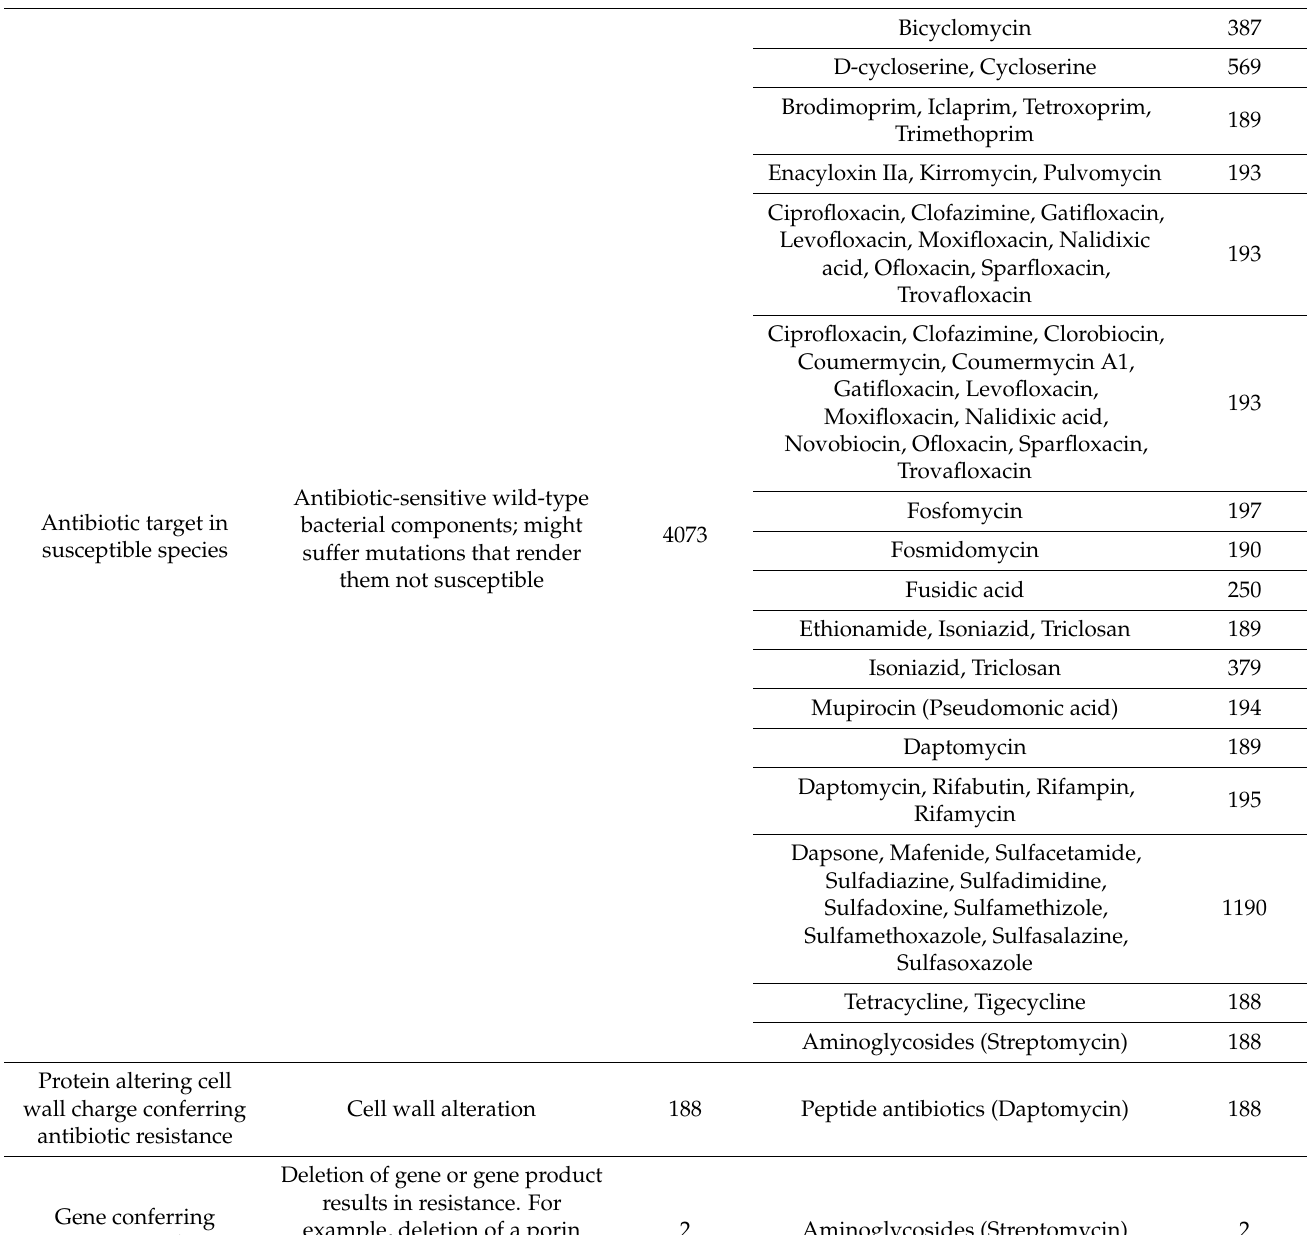
Table 2. Putative ARG detected within 189 A. muciniphila genomes, divided by their mode of action and antibiotic classes. In bold are represented mechanisms that are specific for a certain